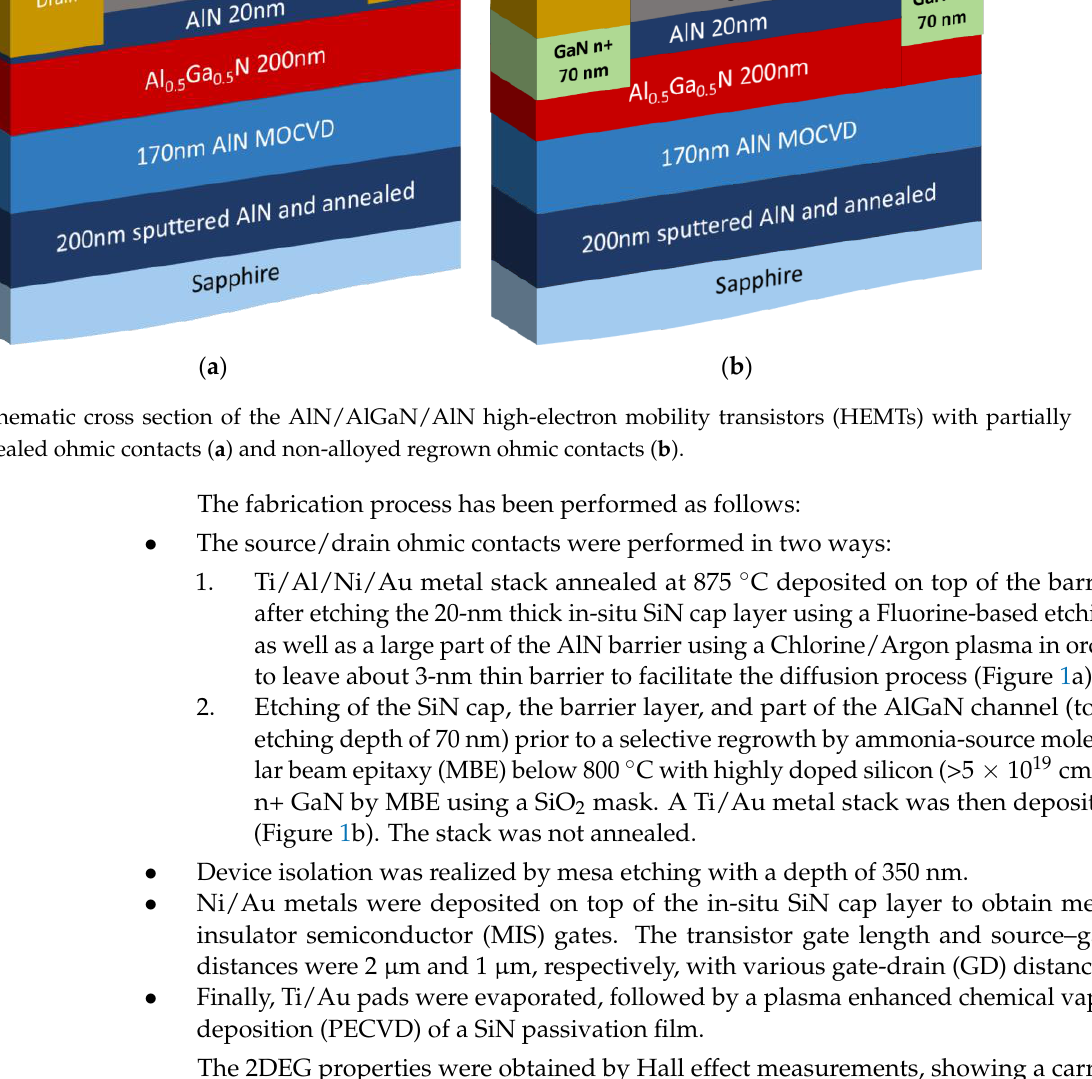
Figure 3. Contact distance dependence on transmission line method (TLM) resistance for re- cessed/annealed and regrown n+ GaN ohmic contacts on the fabricated AlGaN channel HEMTs.